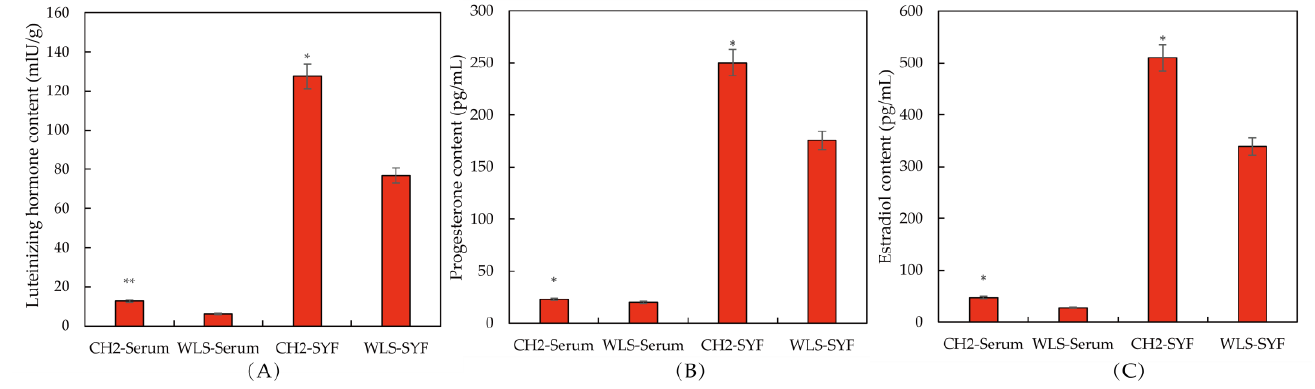
Figure 1. The levels of reproductive hormones in the CH2 and WLS chickens in serum and SYF tissue. ( A ) LH hormone level, ( B ) P4 hormone level, ( C ) E2 hormone level. LH: luteinizing hormone,